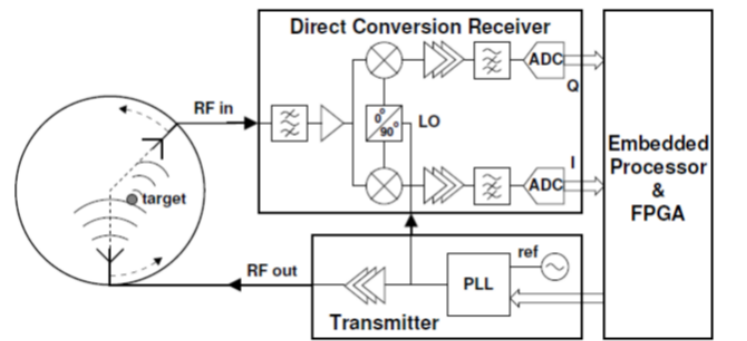
Figure 10. A schematic of the system developed by Pagliari et al. [69]. Reprinted with permission from